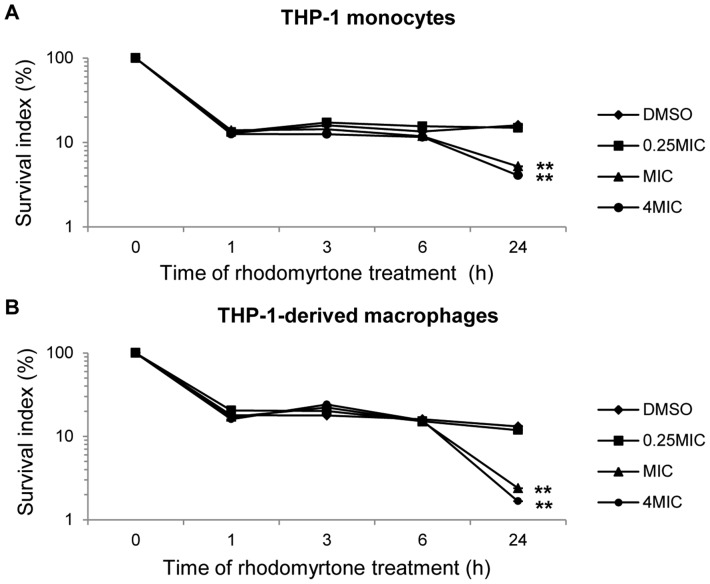
Effect of rhodomyrtone on the bactericidal activity of phagocytes.THP-1 monocytes (A) and PMA-activated THP-1 monocytes (B) were incubated with MRSA at the multiplicity of infection of 1 for 30 min. Cells were treated with rhodomyrtone at 0.0975 (0.25MIC), 0.39 (1MIC), or 1.56 (4MIC) µg/ml for the times indicated. Negative-control cells were treated with the vehicle (0.0078% DMSO) alone. Data are the mean ± SD of 3 independent experiments. ** p<0.01, compared with DMSO controls.